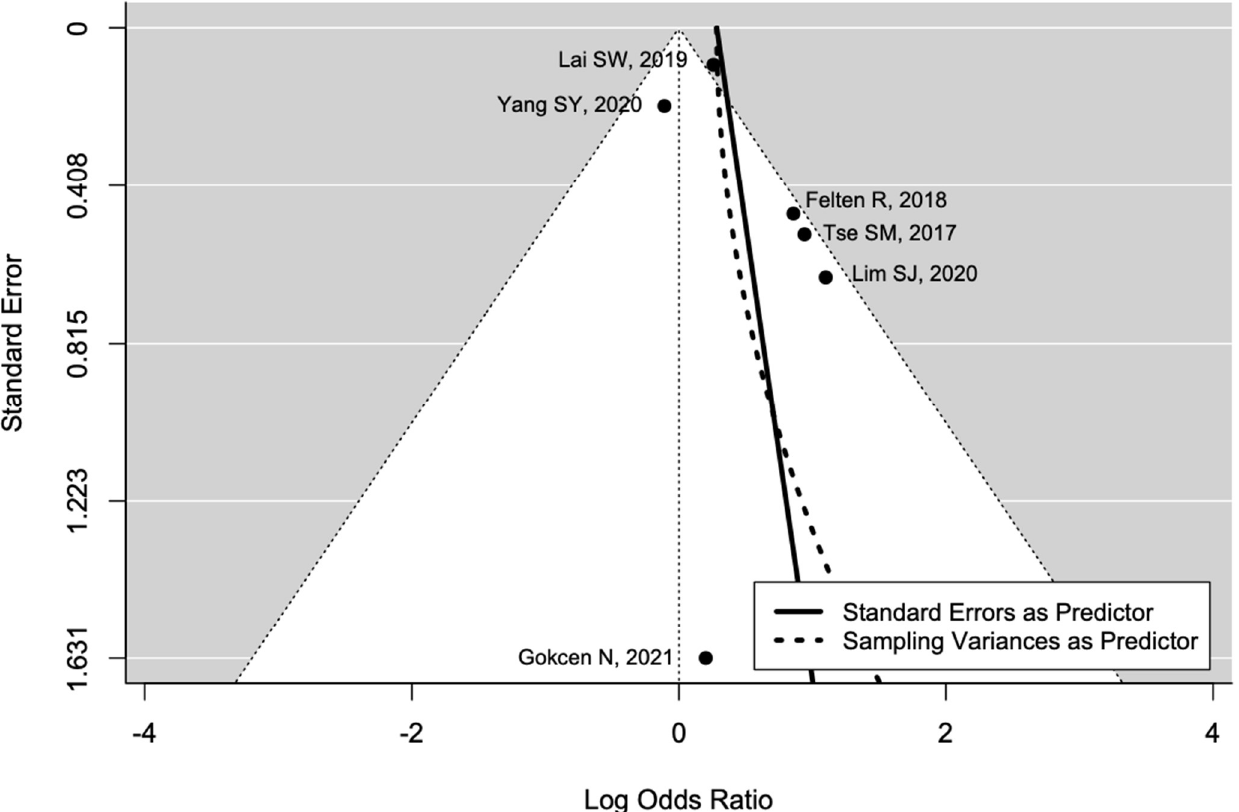
Figure 4. Funnel plot for publication bias